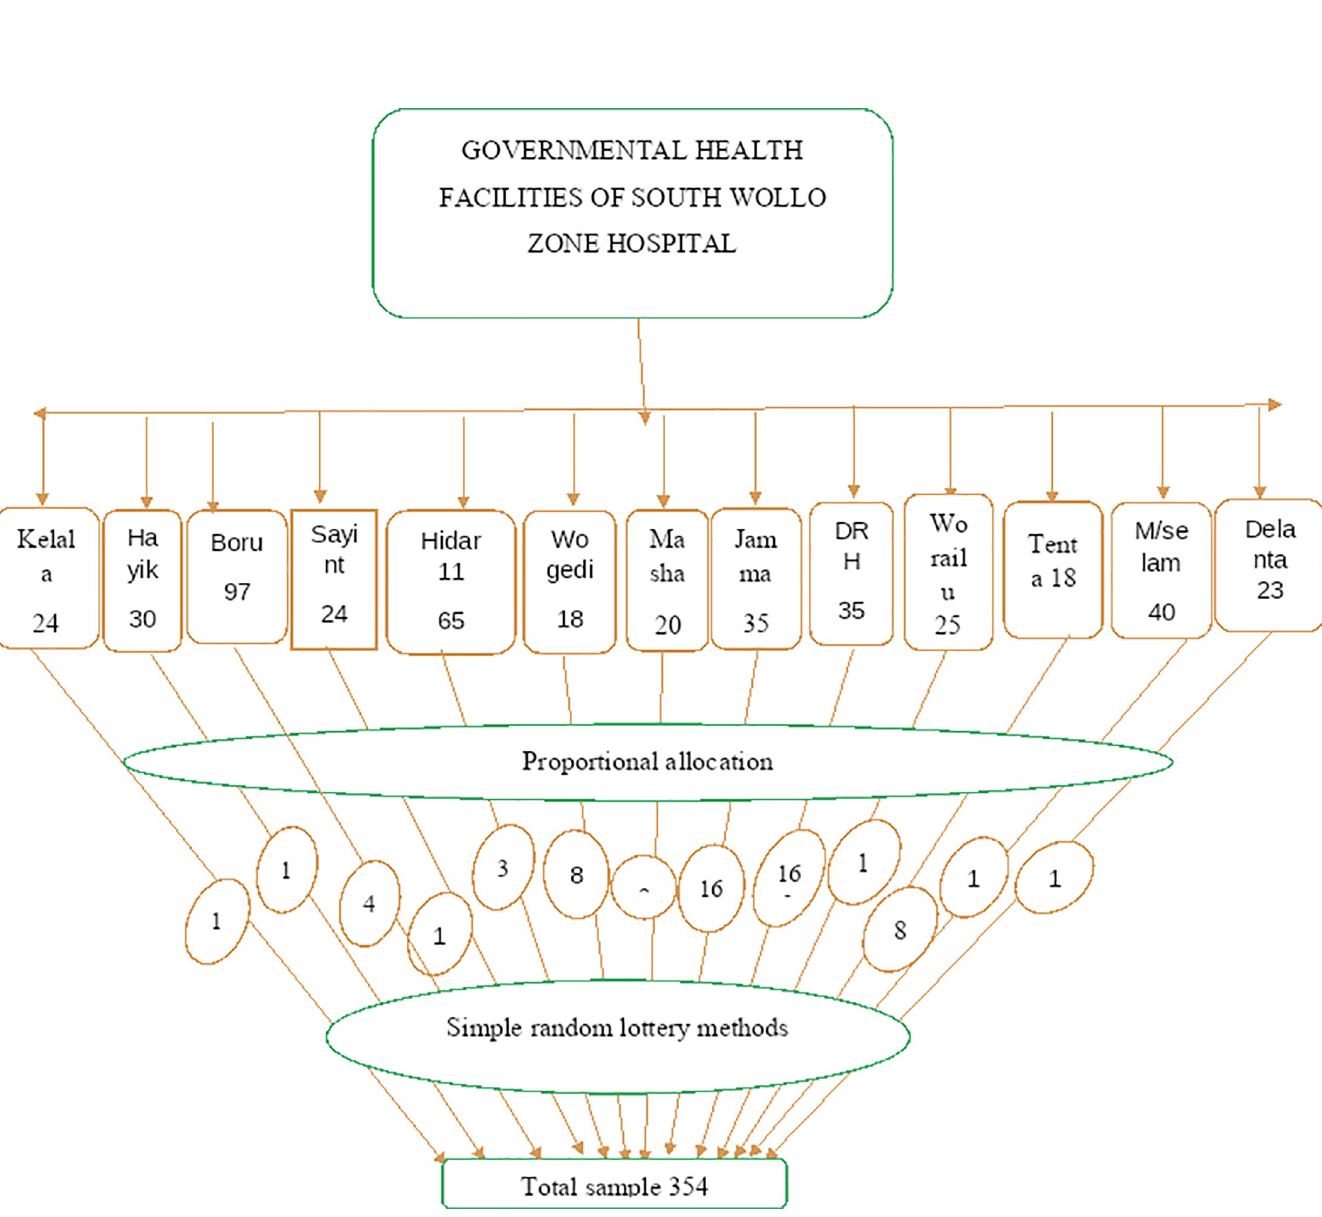
Fig 1. Schematic presentation of sampling procedure for utilization of LARCs in south Wollo zone hospitals 2021.